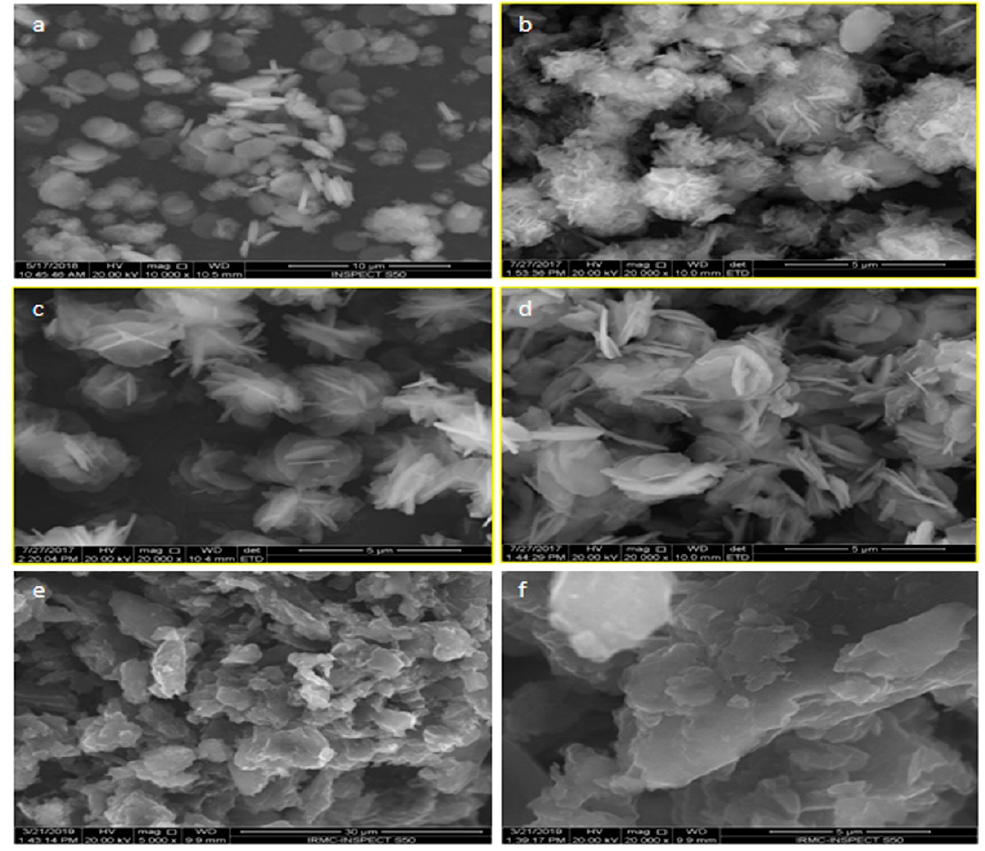
Figure 7. SEM images of: ( a ) Zn-Al LDH, ( b ) Zn-Al-GO1, ( c ) Zn-Al-GO2, ( d ) Zn-Al-GO3 and ( e , f ) The prepared grapheme.